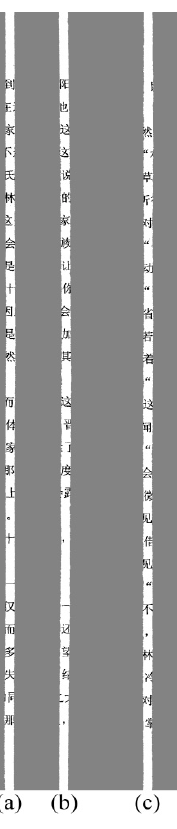
Figure 1. Example of homologous pieces. All the pieces in this figure are derived from the same file: ( a ) and ( b ) belong to the first page of the document; ( c ) and ( d ) belong to the second page of the document; ( e ) and ( f ) belong to the third page of the document.